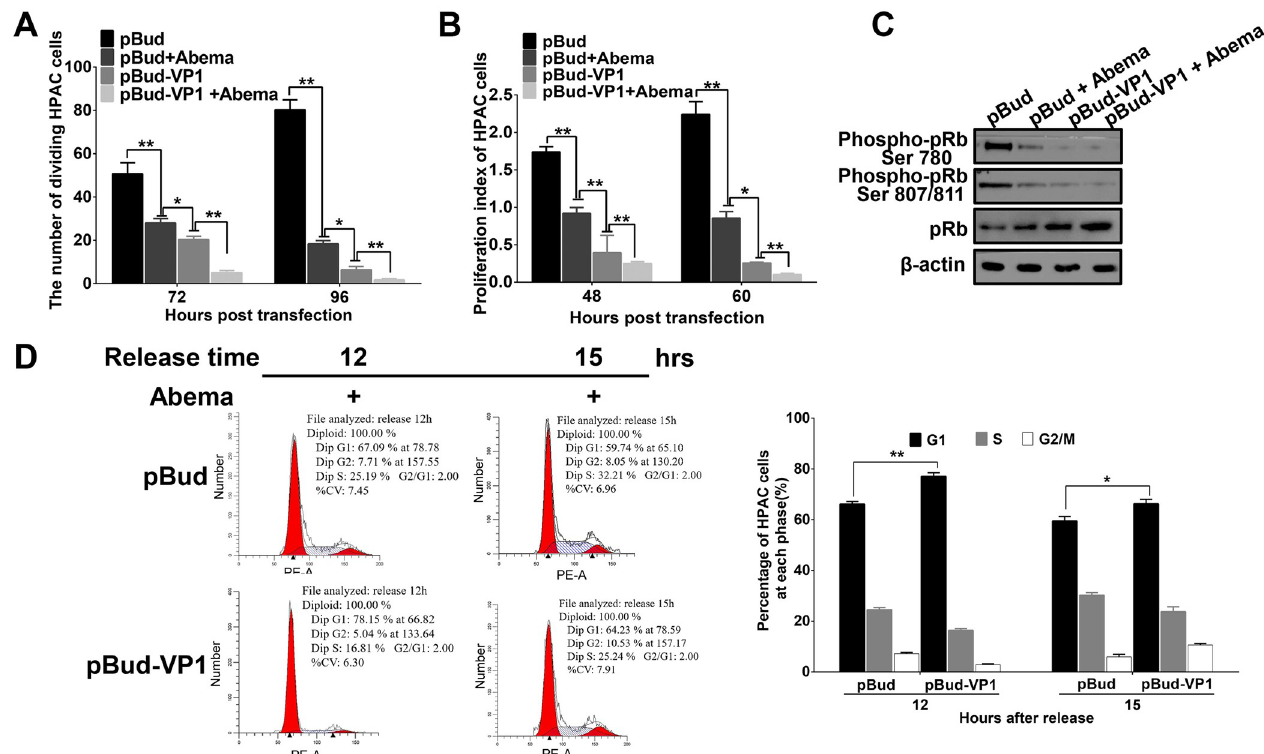
Fig 6. CVB3 VP1 inhibited the activity of CDK4/6 and Rb phosphorylation of the CDK-Rb signaling pathway in the G1/S transition. Abemaciclib (5 mg/ ml stock solution in DMSO) was diluted to a final concentration of 10 μ M in culture medium to treat cells. (A) Abemaciclib (Abema) further inhibits cell proliferation with VP1. An EdU assay was used to analyze the cell proliferation of Mock and pBud-VP1 transfected HPAC cells with or without abemaciclib treatment. (B) Abemaciclib further inhibits cell viability with VP1. A CCK-8 assay was used to analyze the cell viability of Mock and pBud-VP1 transfected HPAC cells with or without abemaciclib treatment. (C) Abemaciclib further inhibits phosphorylated pRb with VP1. Western blotting analysis of the expression of phosphorylated/nonphosphorylated pRb with phosphor-pRb Ser 780, 807/811 antibodies. Original blots are shown in S27 Fig for statistical analysis. (D) CDK4/ 6 inhibitor further inhibits the cell cycle based on pBud-VP1. HPAC cells were treated with pBud and pBud-VP1 transfection within the treatment of the double-thymidine and abemaciclib, then released and separately collected at 12 and 15 hpi; the right figure is flow cytometric results. Values are shown as the mean ± SEM of three independent experiments. ( � P < 0.05, �� P <